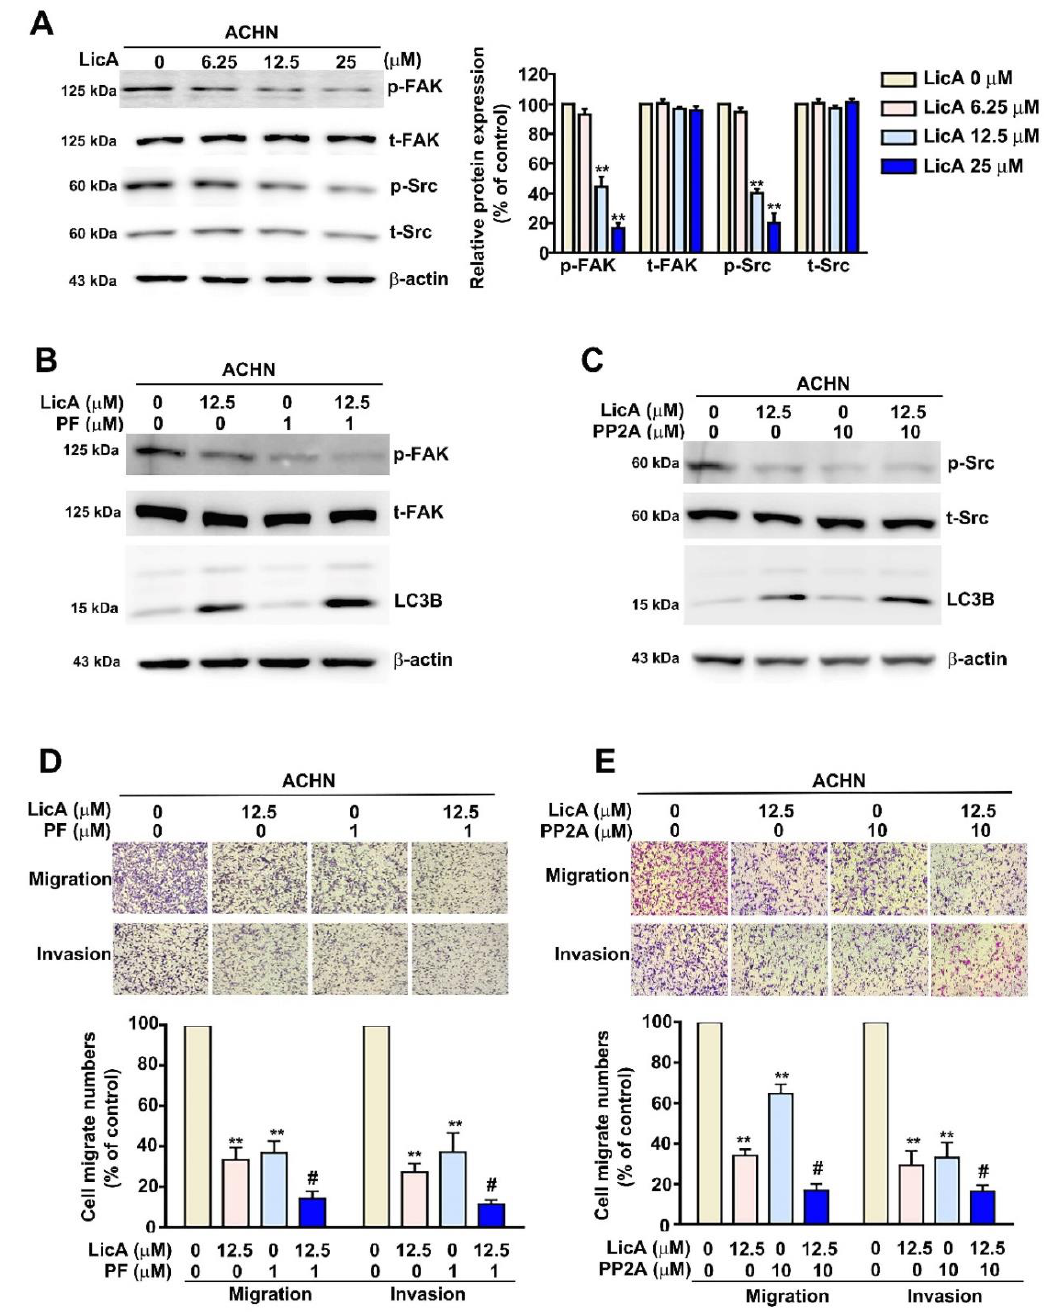
Figure 6. LicA inhibits metastasis via the FAK/Src signaling pathway of RCC cells. Different LicA concentrations (0, 6.25, 12.5, and 12.5 µM) were applied to ACHN cells, and the cells were then left to react for 24 h. ( A ) Western blotting was utilized to examine the expression of p-FAK, t-FAK, p-Src, and t-Src in cell lysates. β-actin served as a internal control. The ACHN cells were treated with 12.5 µM LicA in the presence or absence of ( B ) a FAK inhibitor (PF) or ( C ) an Src inhibitor (PP2) for 24 h. The cell lysates were examined using Western blotting to measure the protein levels of p-FAK, t-FAK, and LC3B. ( D , E ) Next, migration and Matrigel-invasion assays were used to assess migration and invasion. Data represent the mean ± SD of at least three separate experiments. ** p < 0.01, compared to un-treated control (0 µM); # p < 0.05, compared with LicA-treated alone. As previously reported in relation to application in cervical cancer cells, we chose 20 mg/kg as the experimental dose in order to exert an effective antitumor effect and avoid